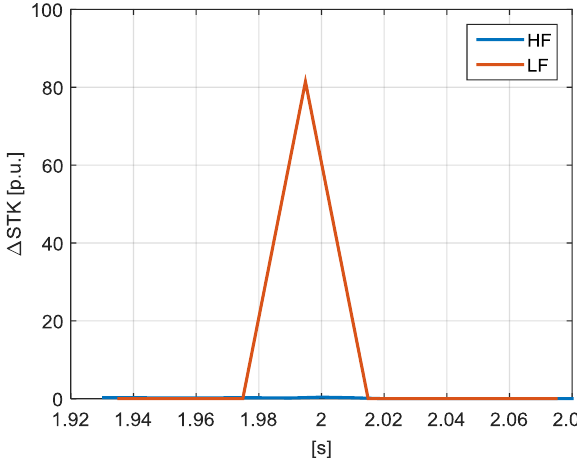
Figure 24. Case study 3: Δ STK at low-frequency (0 ÷ 2.4 kHz, red line) and at high-frequency (2.4 ÷ 150 kHz, blue line) obtained through the late approach.